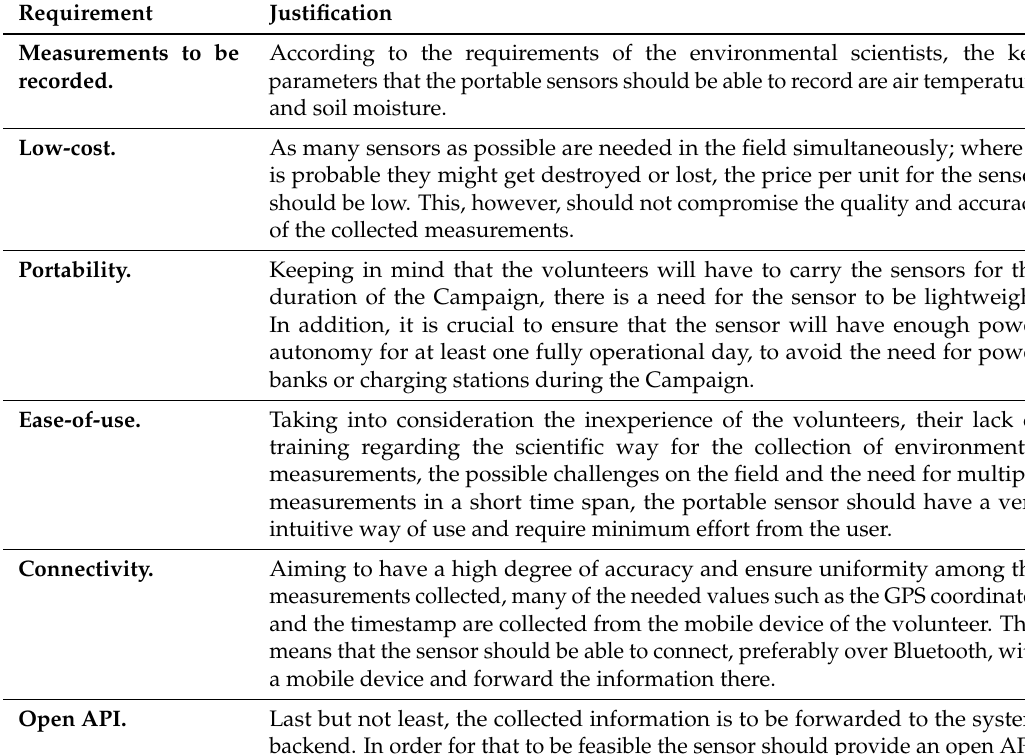
Table 1. Requirements for portable